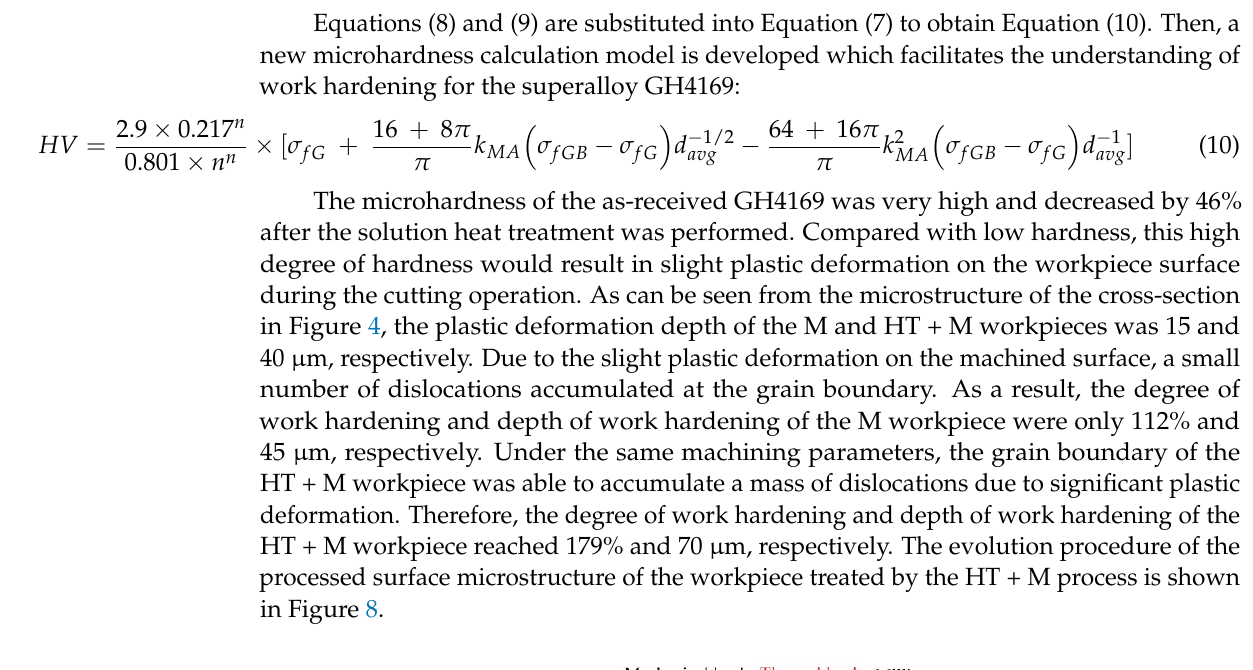
HT + M workpiece reached 179% and 70 µ m, respectively. The evolution procedure of the processed surface microstructure of the workpiece treated by the HT + M process is shown in Figure 8.